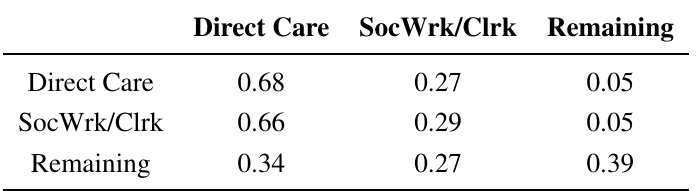
Table 6. Observed hospital worker contact shares. The values in the table represent the fraction of contacts of the row group that come from the column